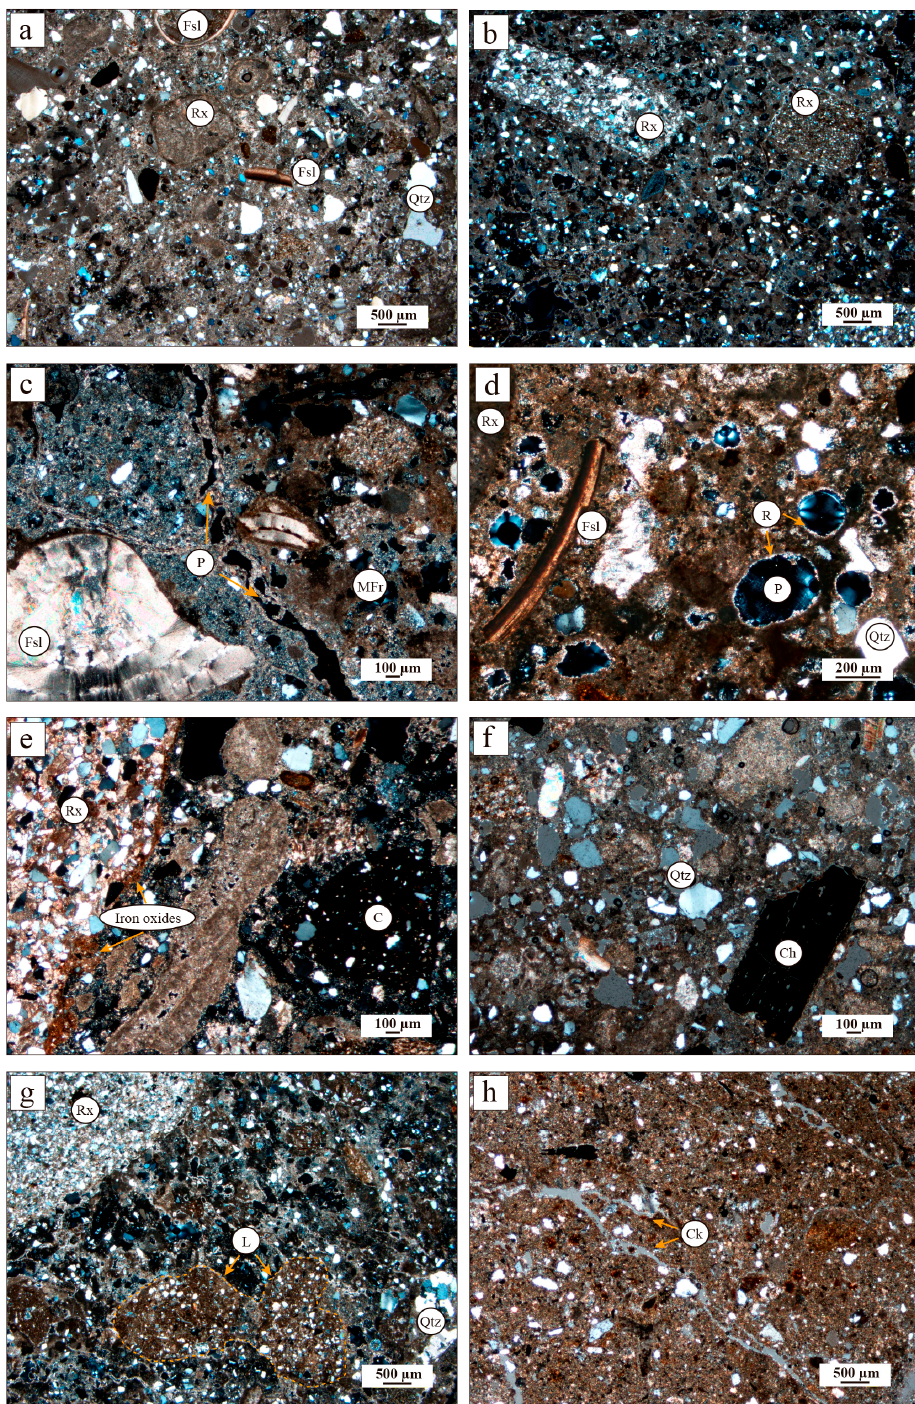
Figure 4. Photomicrographs show the most representative textural features of historic lime mortars from Irulegi Castle. ( a ) Mortar with quartz grains and rock and fossil fragments, ( b ) mortar with angular fragments of sandstone and ( c ) mortar with fossil (left) and reused mortar (right) fragments. Porosity between the mortar fragment and the matrix can be observed, ( d ) mortar with pores that show recrystallizations inside, ( e ) mortar with rounded ceramic fragment, ( f ) mortar with charcoal fragment, ( g ) mortar with quartz-bearing lumps and ( h ) mortar matrix with microcracks. C: ceramic, Ch: charcoal, Ck: crack, Fsl: fossil, L: lump, MFr: Mortar fragment, P: pore, Qtz: quartz, R: recrystallization, Rx: rock fragments.